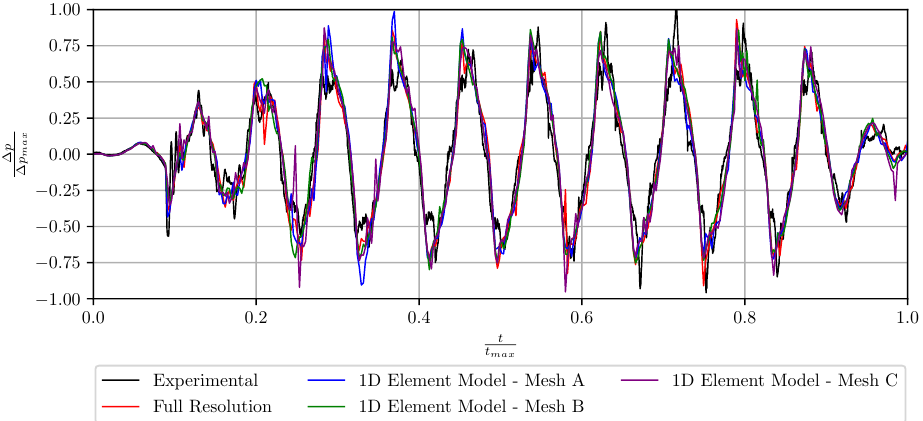
Figure 13. Comparison of pressure difference, p 1